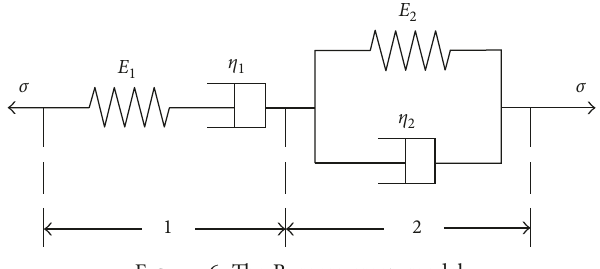
Figure 6: The Burgers creep